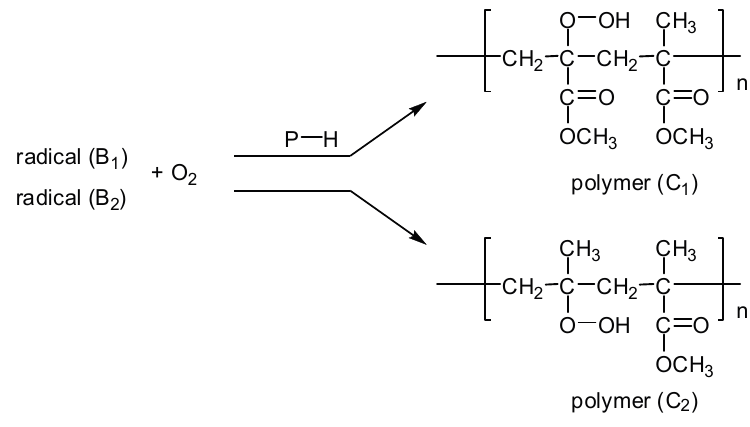
Figure 4. Formation of hydroperoxide polymers C 1 and C 2 .